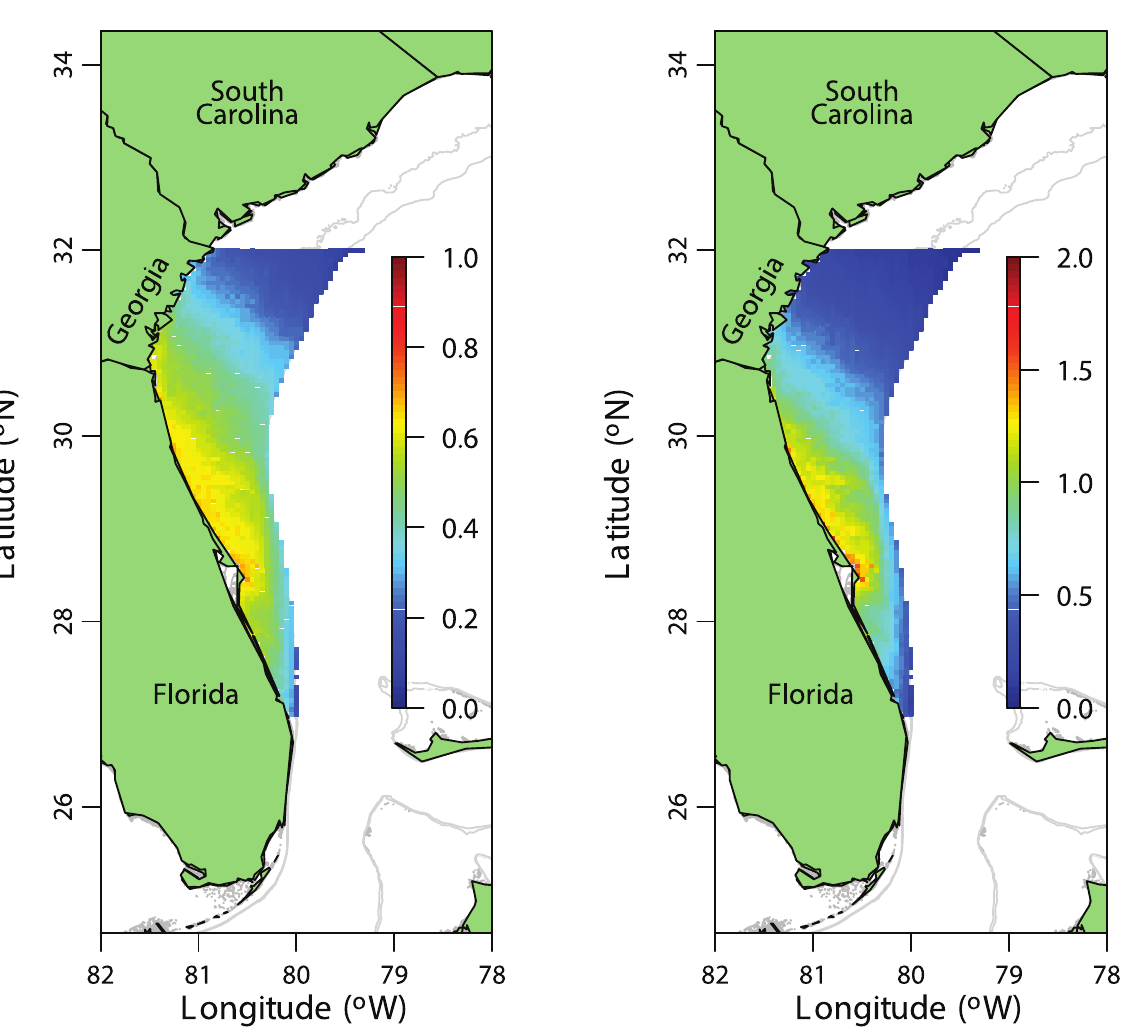
Figure 4. Mean site occupancy probability and abundance of red snapper in reef habitat off the coasts of Georgia and Florida. Estimated mean occupancy probability of reef sites from the basic occupancy model (left panel) and abundance from the Royle-Nichols model (right panel) as a function of depth and latitude.